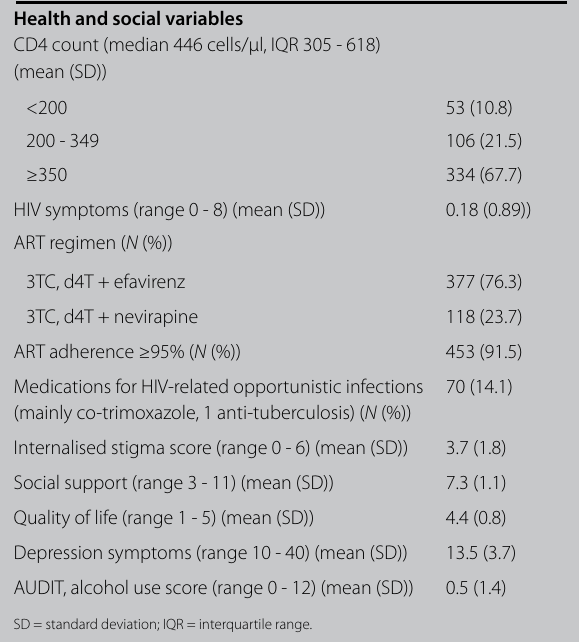
Table I. Sample characteristics ( N =495